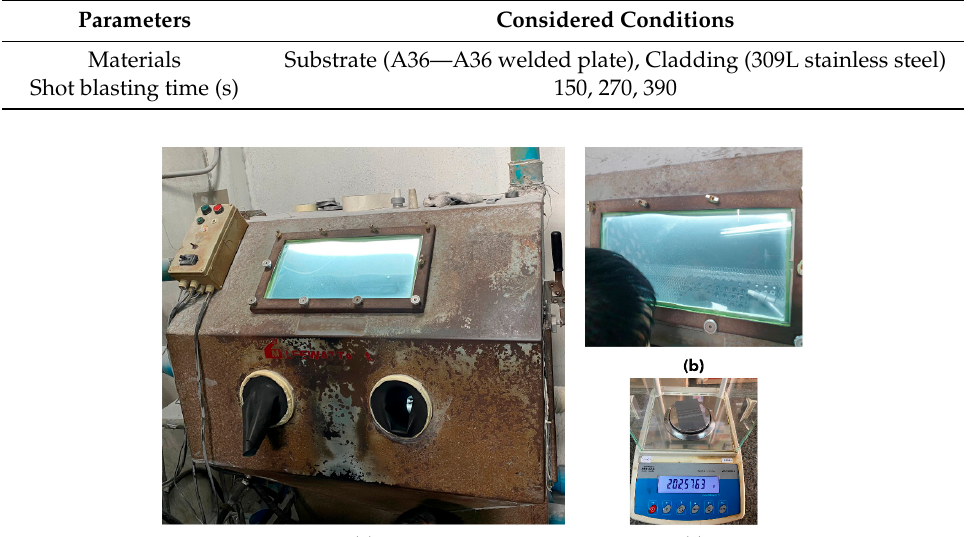
Figure 8. The shot blasting wear test: ( a ) Shot blasting machine; ( b ) Specimen placement in the shot blasting machine; ( c ) Weight loss measurement after shot blasting. blasting machine; ( c ) Weight loss measurement after shot